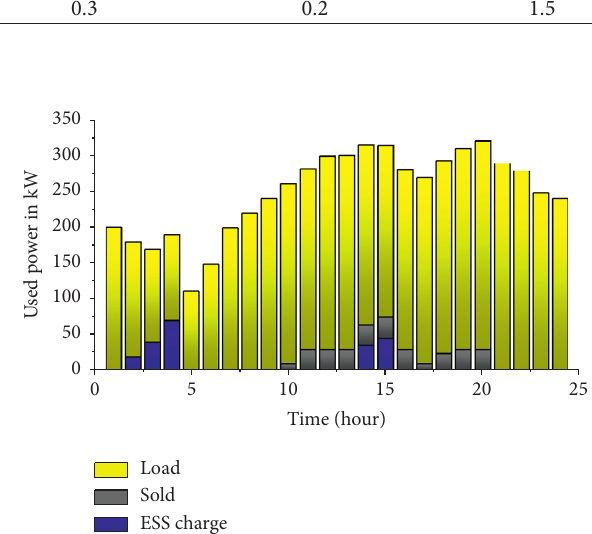
Figure 7: The optimum power consumption in the MG (the basic